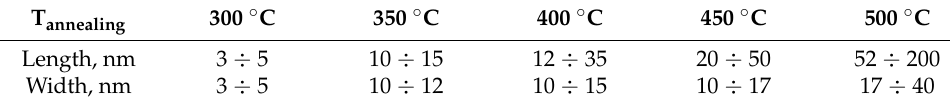
Table 1. Ti 3 Ni 4 particle sizes evolution depending on the aging